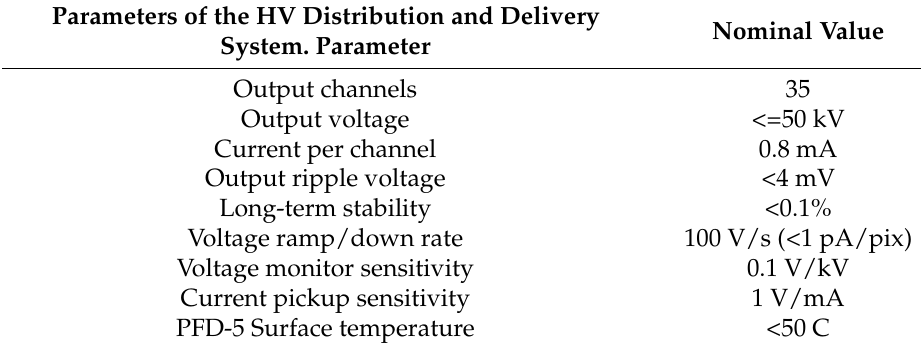
Figure 13. Electrical scheme of field shell current monitoring circuit. The summary of the key design parameters of the HV system is given in Table 9. Table 9. ND-M3 capability requirements for